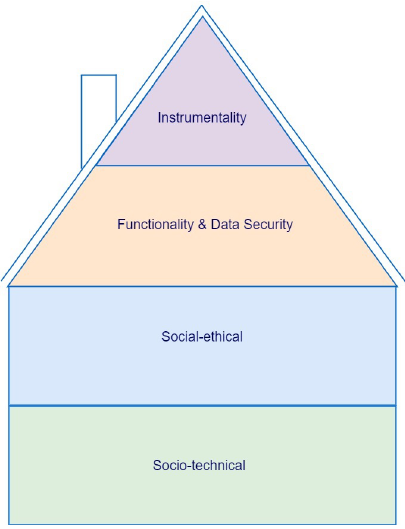
Figure 1. The most important aspects of an Active and Assisted Living smart